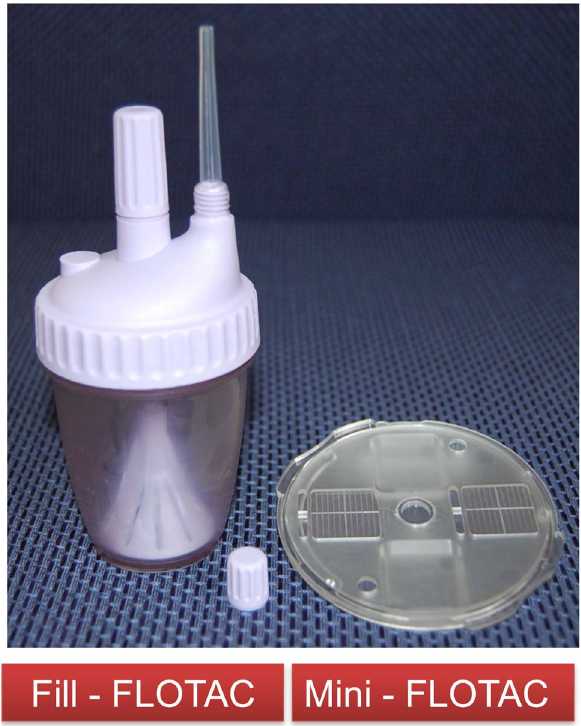
Figure 1. The fill-FLOTAC and the mini-FLOTAC kit.